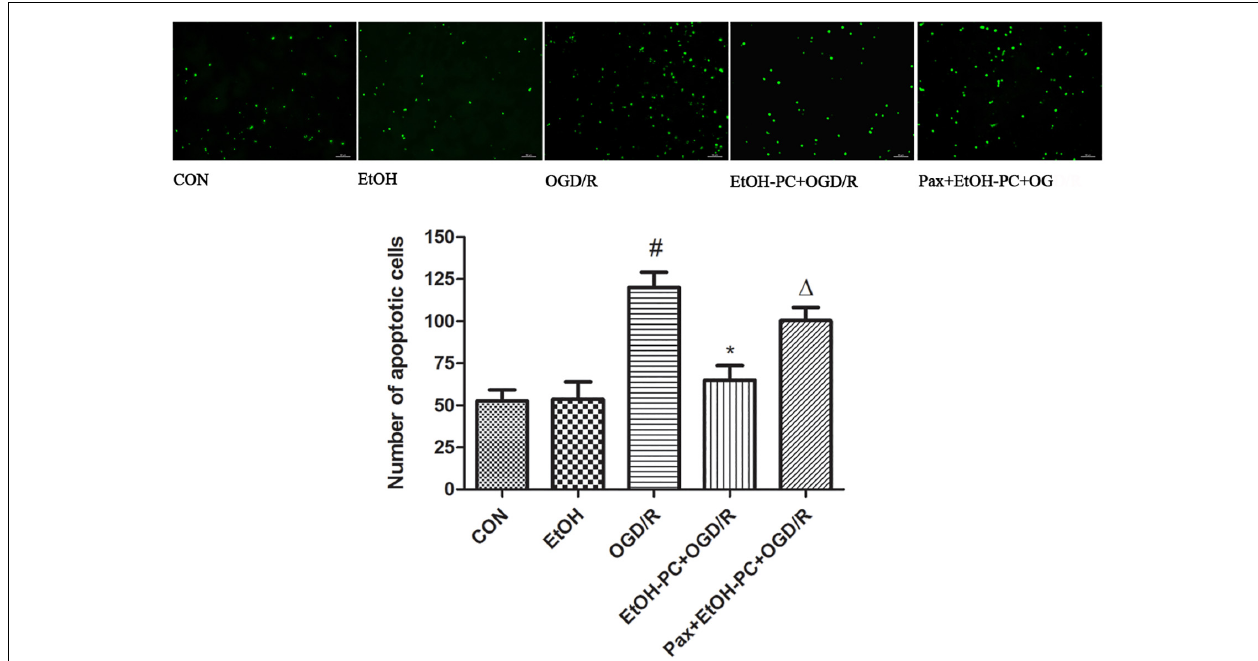
FIGURE 3 | Ethanol preconditioning protected against the OGD/R-induced neuronal apoptosis through activating BK Ca channel detected by TUNEL staining. Results are expressed as mean ± S.D. ( n = 5). # P < 0.01 vs. CON; * P < 0.01 vs. OGD/R; (cid:49) P < 0.05 vs. EtOH-PC + OGD/R; scale bar: 100 µ m.